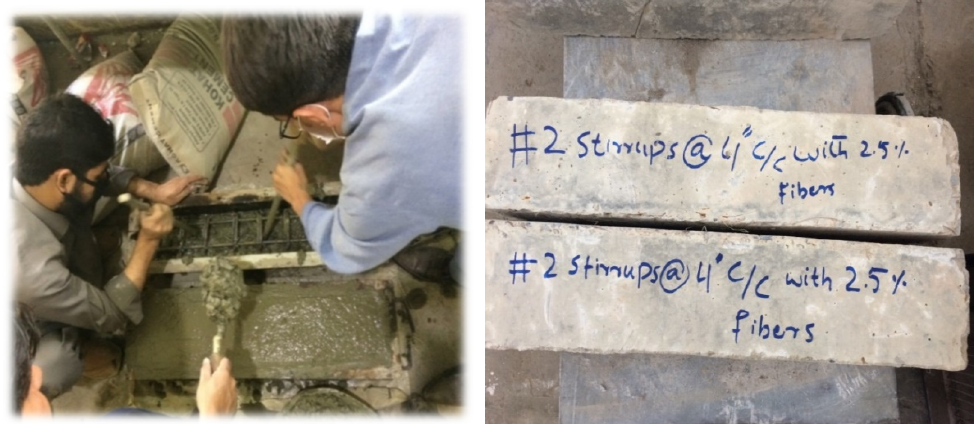
Figure 5. Casting of column specimen with and without fibers reinforcement.